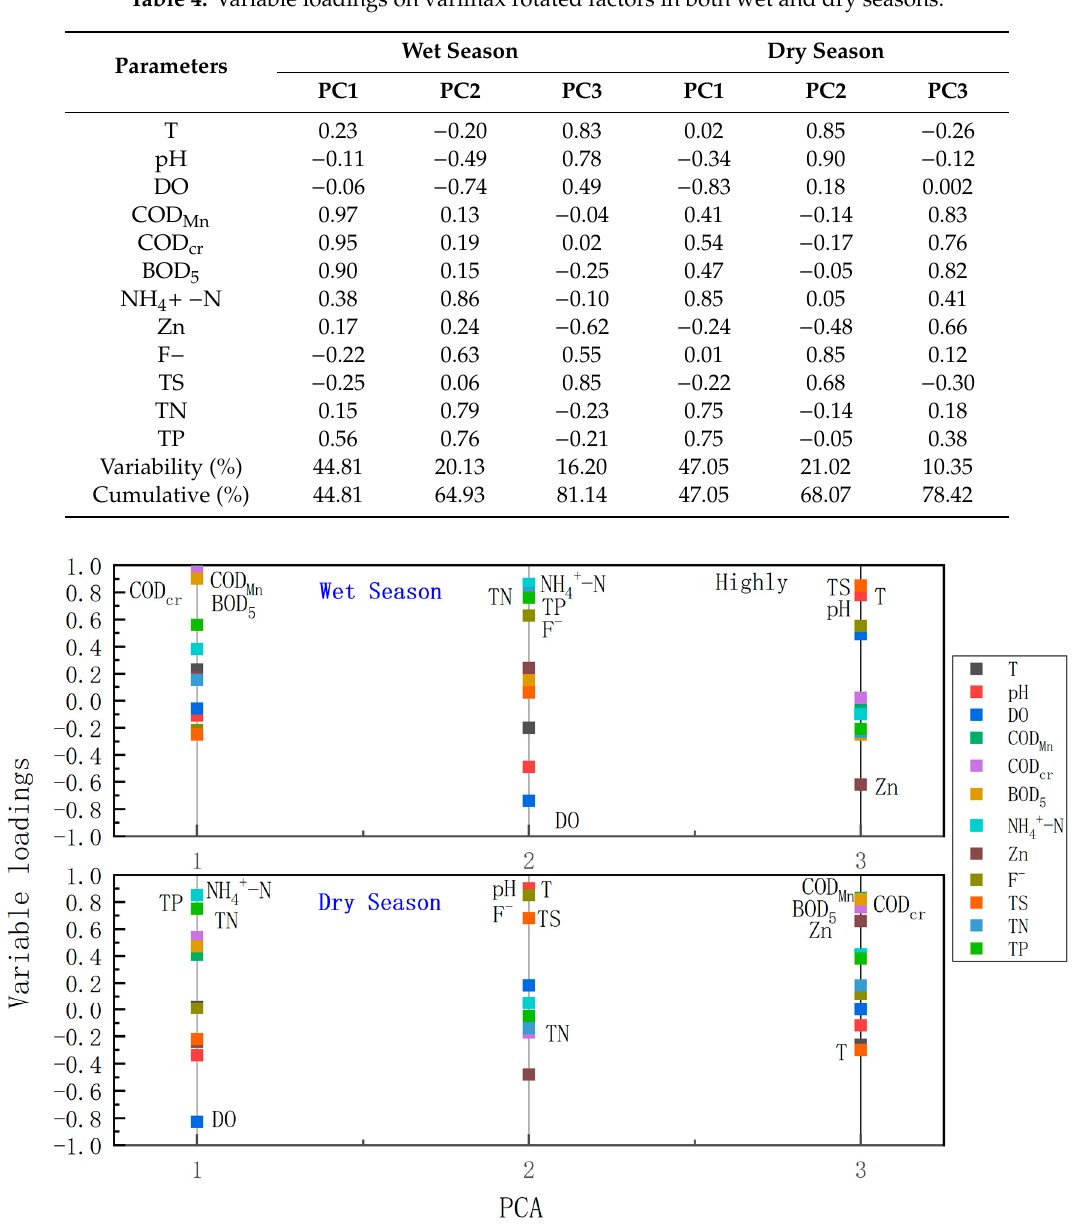
Table 4. Variable loadings on varimax rotated factors in both wet and dry seasons.